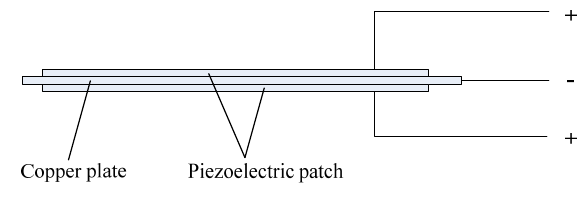
Figure 1. Structure of PCP. Table 1. Parameters of the device materials.